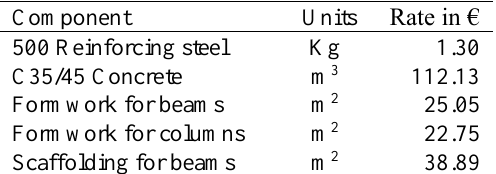
Table 2. Unit cost (rate) for the components